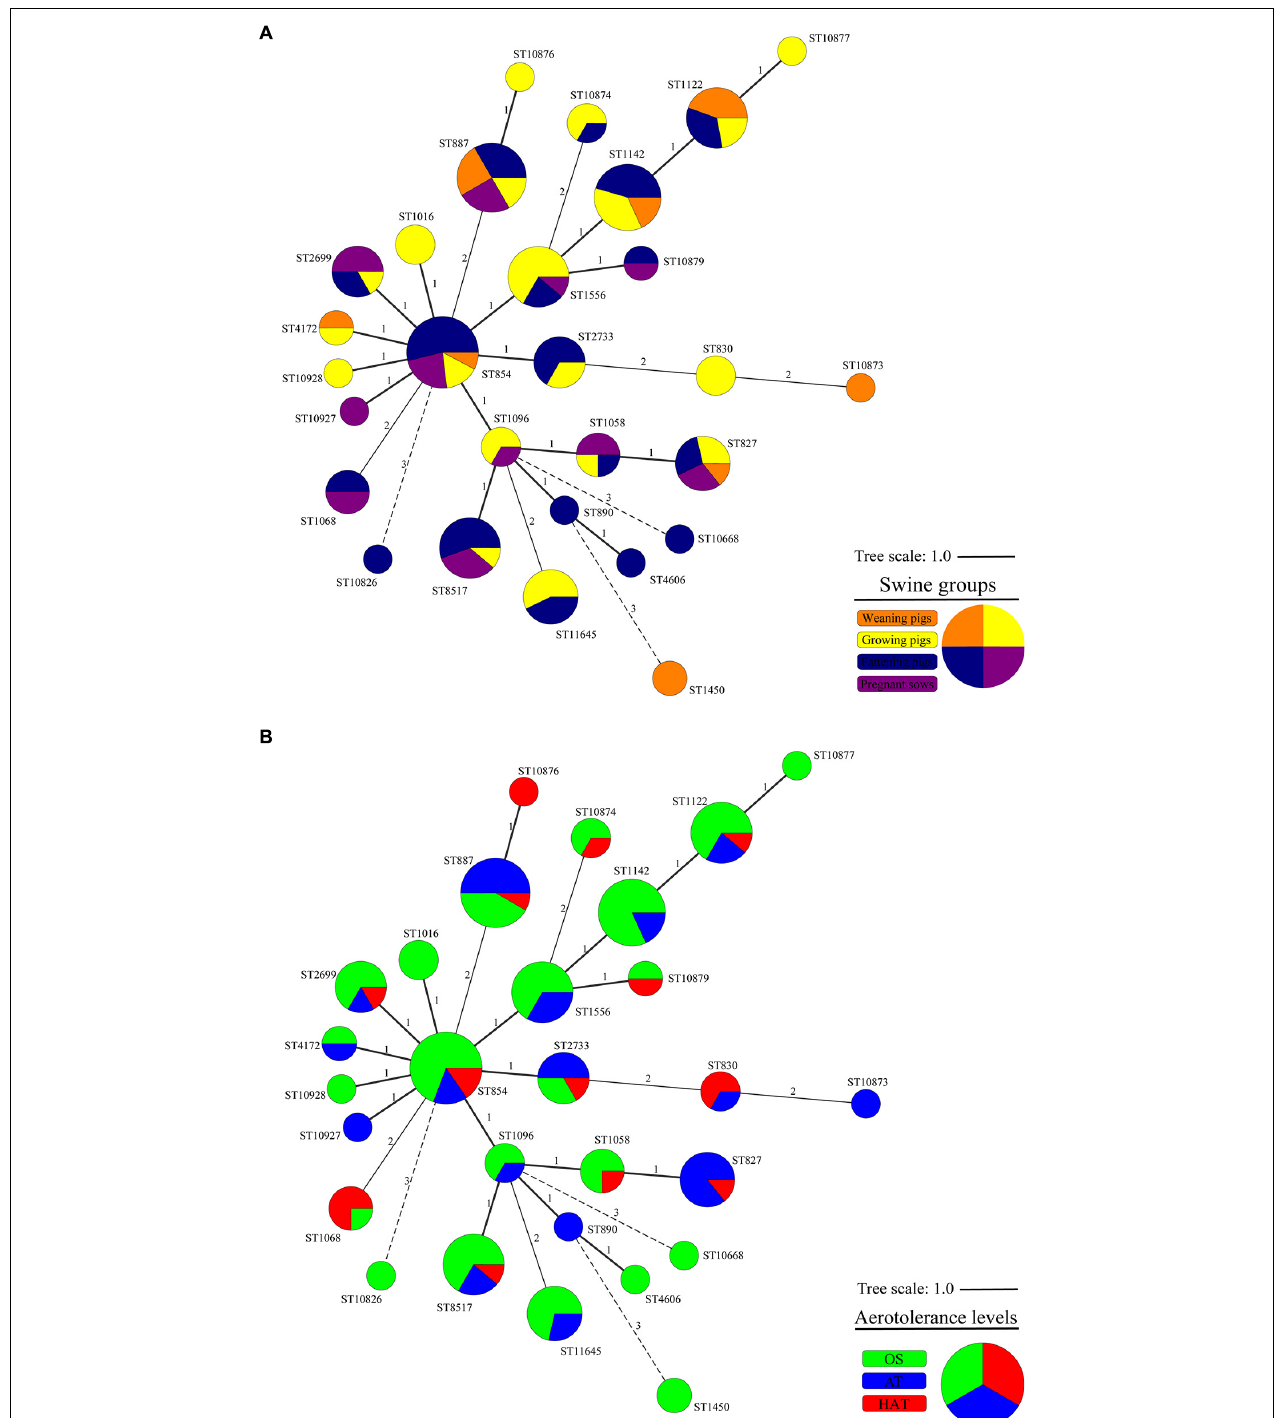
FIGURE 1 | Cluster analysis of 124 Campylobacter coli isolates by multilocus sequence typing (MLST) sequence types (STs) according to (A) the swine groups and (B) the aerotolerance levels of C. coli isolates. A minimum spanning tree (MST) was constructed based on the allelic profiles of MLST housekeeping genes for 124 C. coli isolates. Each node represents the MLST ST, and the size of each node indicates the number of isolates belonging to each MLST ST. Colors indicate (A) the swine groups from which C. coli isolates were isolated (orange, weaning pigs; yellow, growing pigs; navy, fattening pigs; purple, pregnant sows) and (B) aerotolerance levels of C. coli (green, oxygen-sensitive, OS; blue, aerotolerant, AT; and red, hyper-aerotolerant, HAT). The numbers on the branches present the degree of difference in allelic profiles for housekeeping genes.